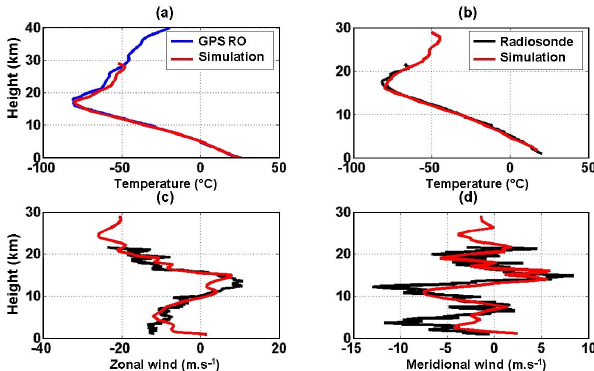
Fig. 5. Observed (black – radiosonde; blue – GPS RO) and sim- ulated (red) vertical profiles of (a) temperature from GPS RO at (19 ◦ S, 59 ◦ E) on 15 February at 00:26UTC (00:00UTC), (b) tem- perature of radiosonde at Gillot on 16 February at 11:12UTC (12:00UTC), and radiosonde zonal wind (c) and meridional wind (d) at Gillot on 16 February 2008 at 11:12UTC.